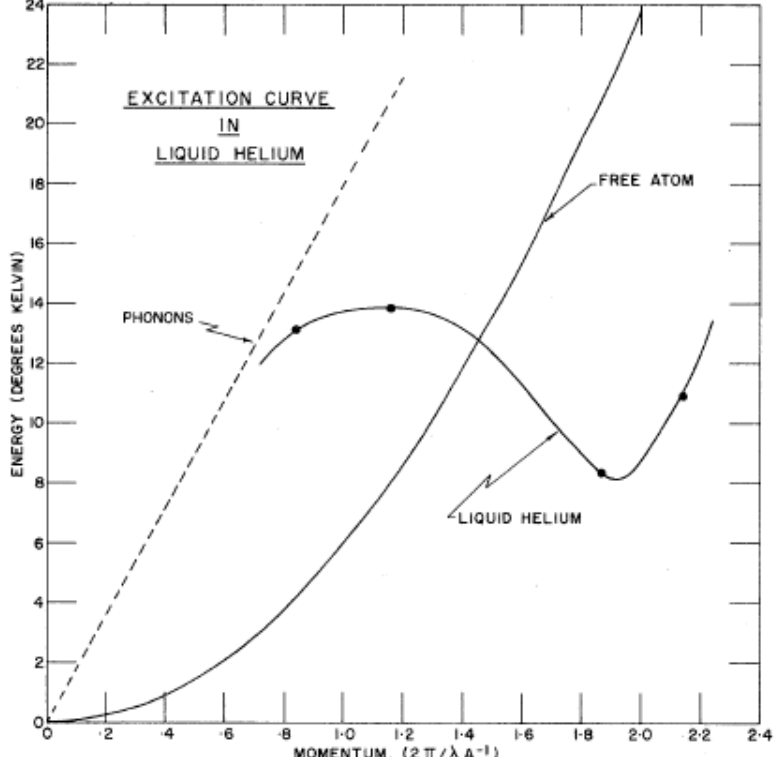
Figure 11. The excitation curve in superfluid He 4 . The points represent the measured change in energy and momentum of the scattered neutrons. The smooth curve drawn through the points is a guide to the eye and gives the expected form of the excitation curve. The minimum is around 1.93 Å − 1 and 8.1 K, which corresponds to the minimum of the Landau roton curve. The parabolic curve represents the excitation of free He 4 atoms, while the dotted curve gives the calculated phonon excitation curve for a velocity of sound of 237 ms − 1 . This figure is taken from Figure 1 of ref. [40]. Copyright by the American Physical Society.